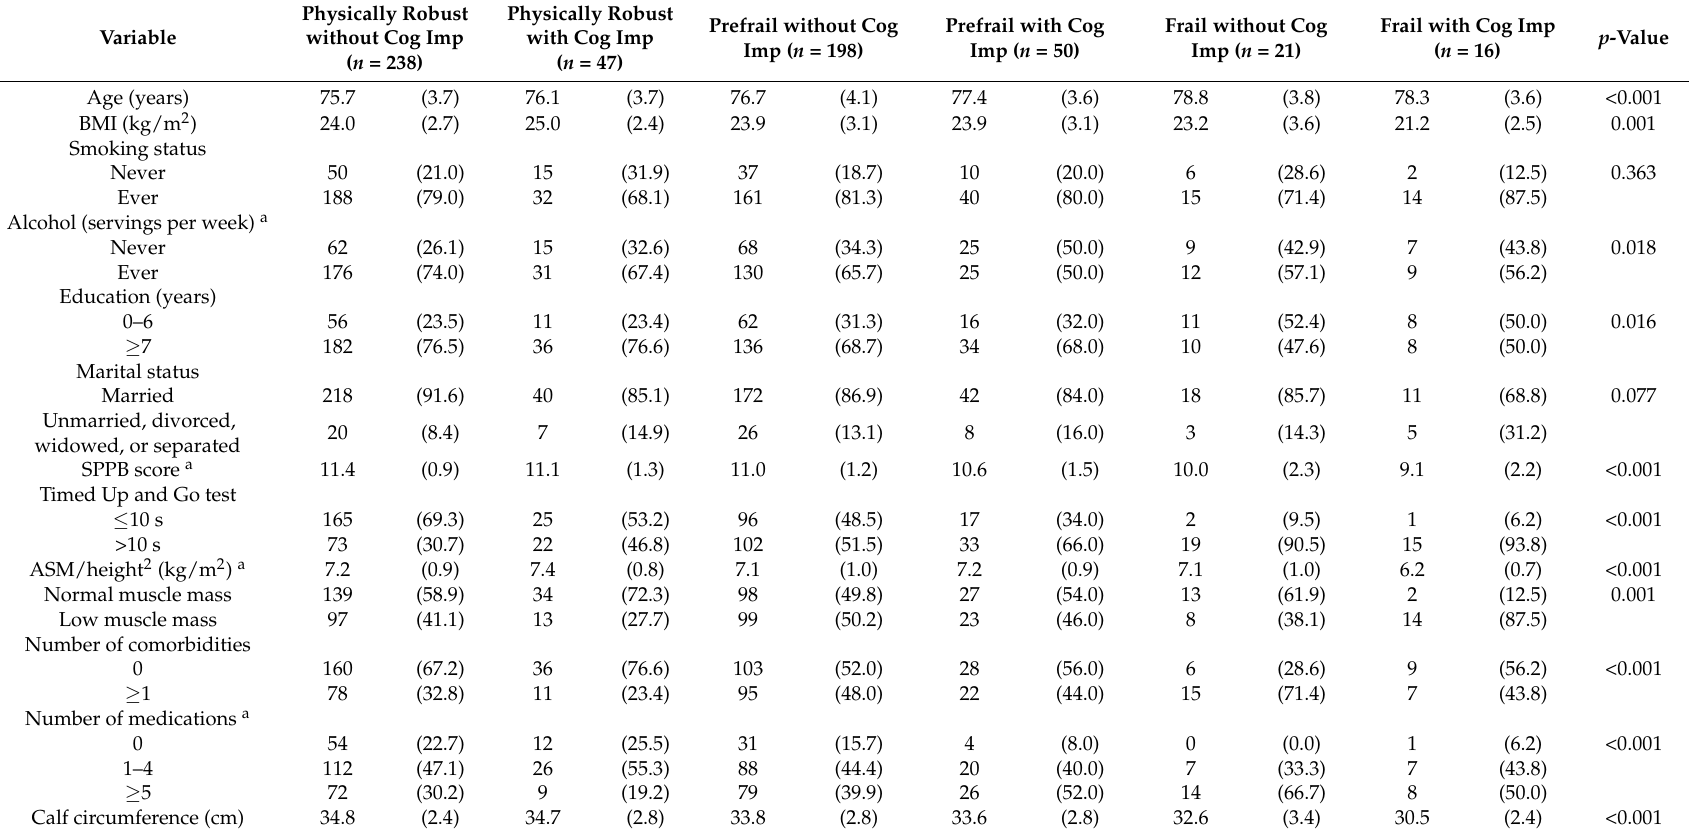
Table 1. Characteristics of the male participants ( n = 570) according to physical frailty and cognitive impairment